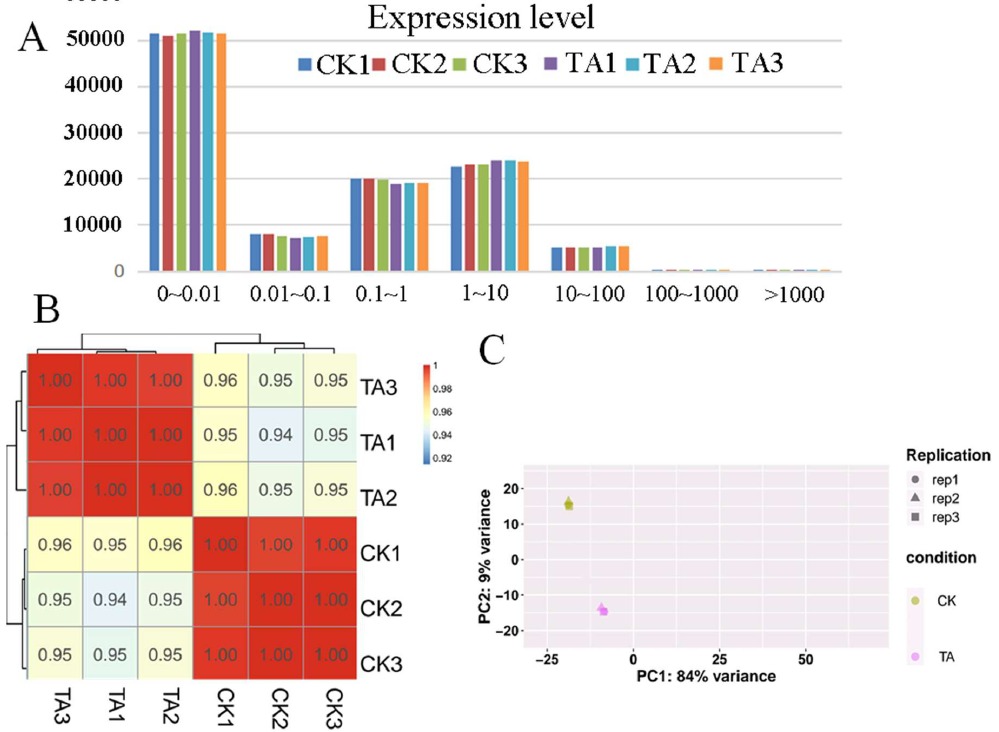
Figure 4. Di ff erent treatment samples analysis. ( A ). The calculation of expression level in strawberry fruit under TA ( triacontanol ) treatment. A total of 108,087 genes were identified and the number of genes in di ff erent sections were similar among both control and TA-treated. ( B ). Correlation matrix showed the correlation between samples. Both the CK ( control ) and TA-treated had the darkest colors, indicating that the correlation between the same treatment samples was the highest. ( C ). Principal Component Analysis (PCA) were performed on the biological replicates of each sample set (CK and TA), which the same treatment samples were closed, indicating the higher similarity between